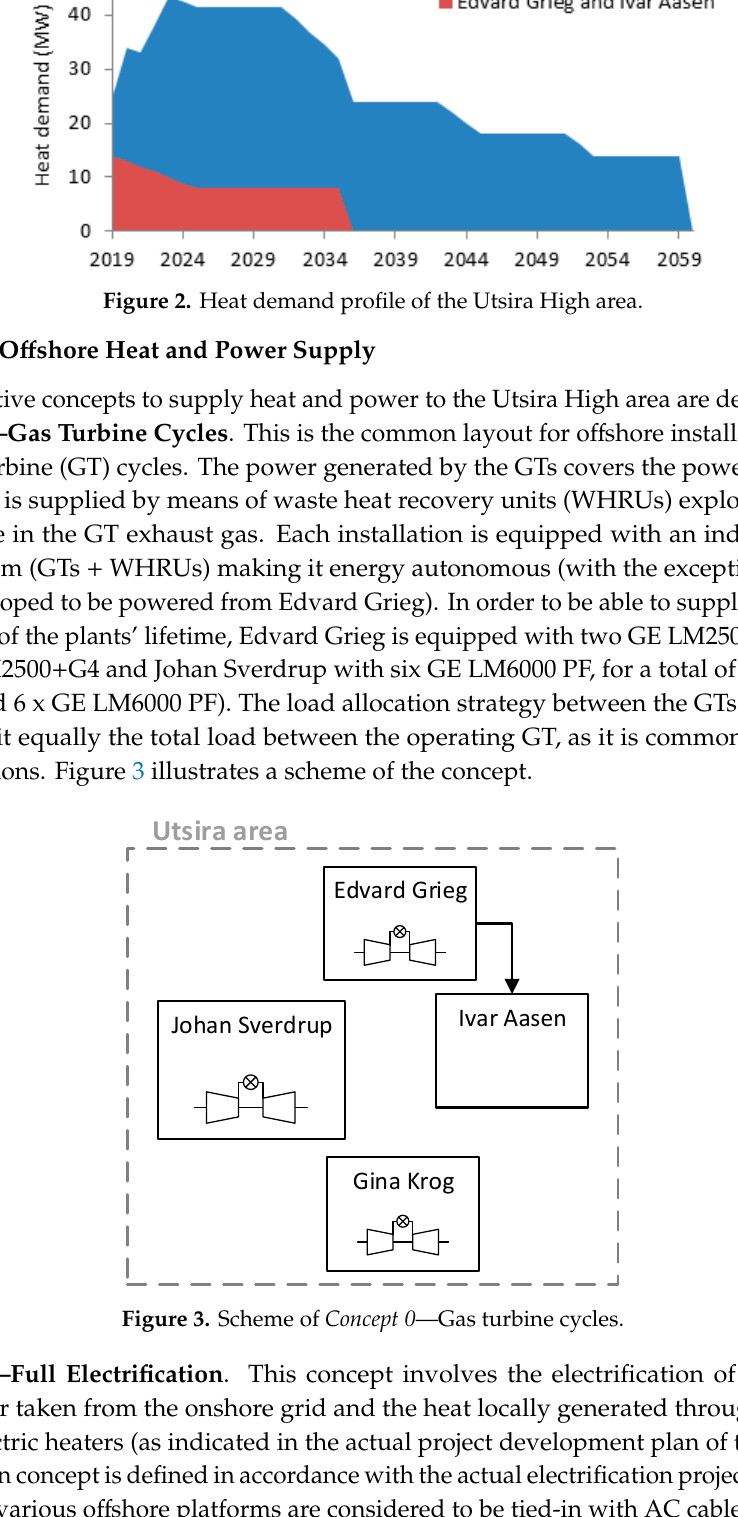
Figure 2. Heat demand profile of the Utsira High area.